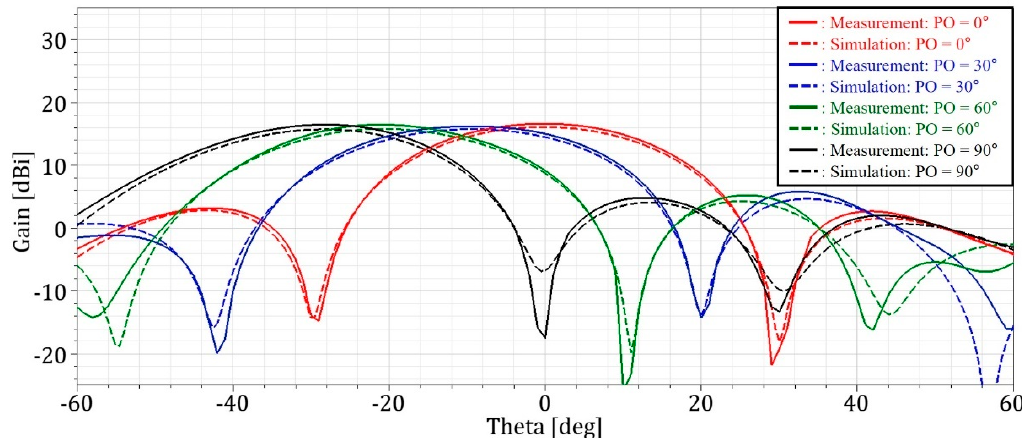
Figure 18. Simulated and measured radiation patterns of 4 × 4 antenna array in the absence of the lens.